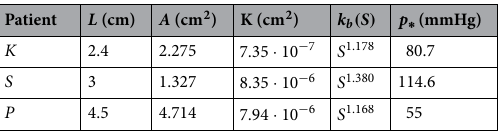
Table 1. Geometrical and filtration characteristics of AVM reconstructed from clinical